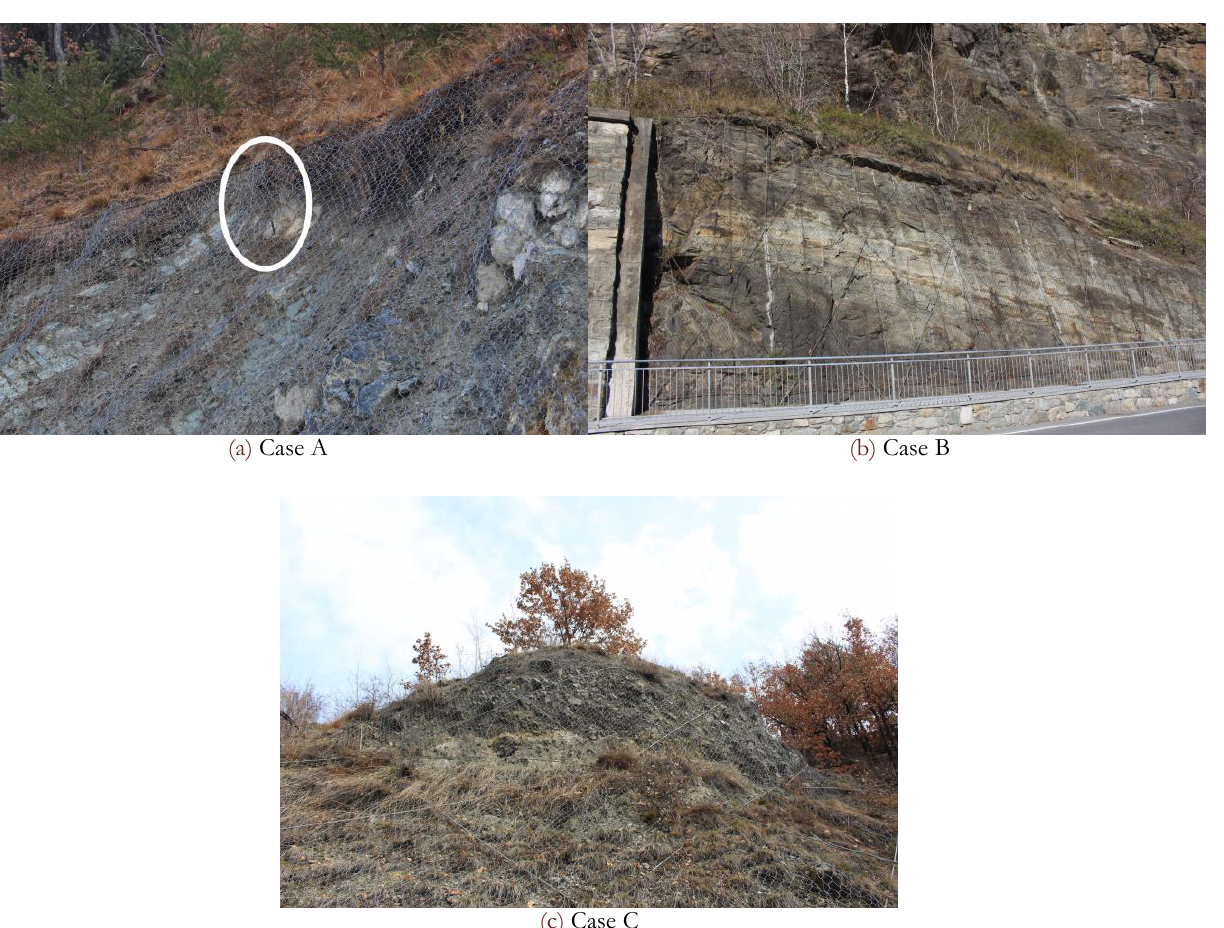
Figure 5: Photos of three installations observed during the site campaign: Case A is a simple drapery mesh system, the unthreaded anchor is marked with the white circle. Case B and Case C refer to reinforced drapery systems.